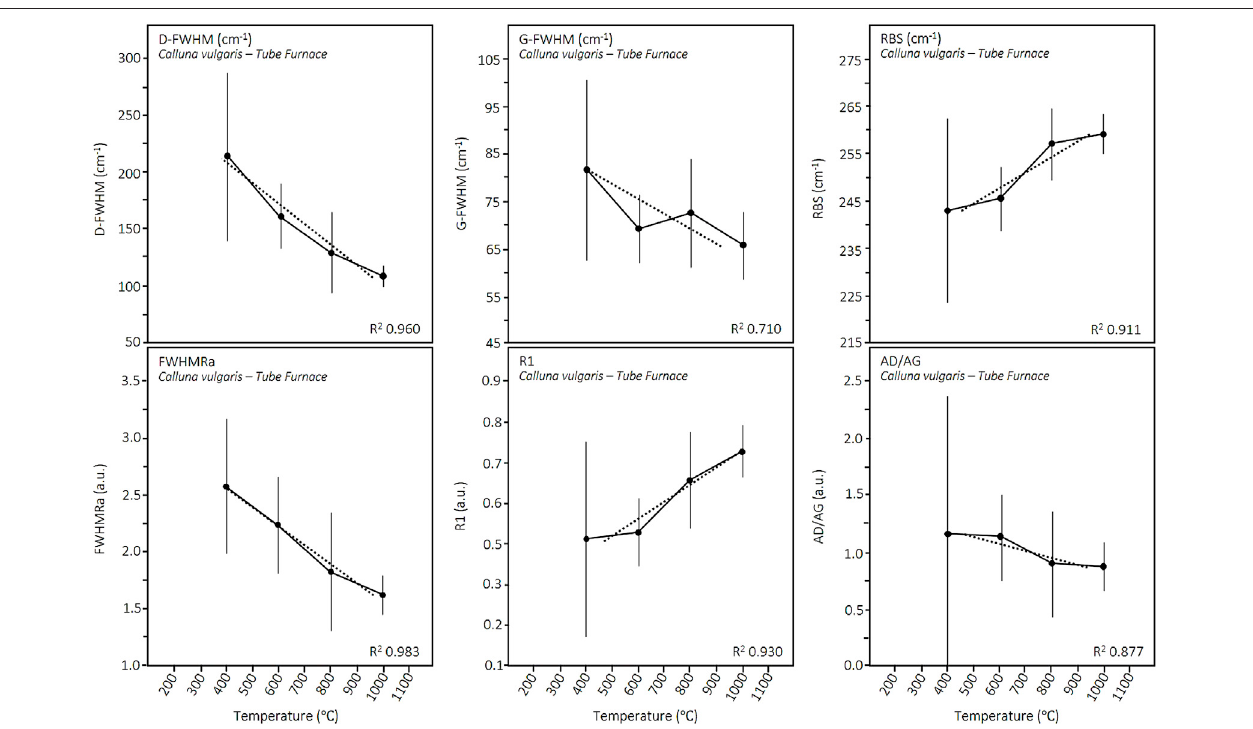
FIGURE 2 | Crossplots indicating the relationship between temperature of charcoal formation and Raman parameters — derived from tube furnace pyrolysis. Each data point re fl ects median values from 150 individual spectral deconvolutions, with standard deviations shown by vertical black lines. Linear trends are indicated by dotted grey lines, corresponding to R 2 values denoted in the bottom left corner of each